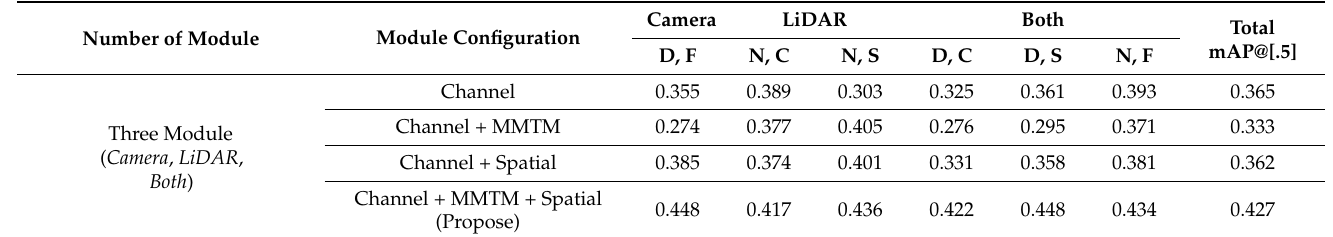
Table 6. Object detection performance according to module configuration. Network backbone use